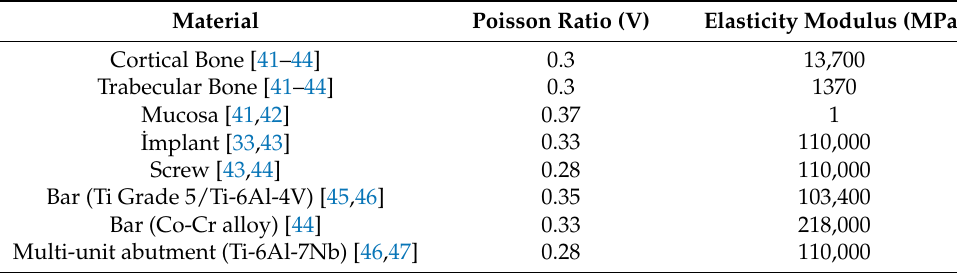
Table 1. The elasticity modulus and the Poisson ratio of each material used in this study. Material Poisson Ratio (V) Elasticity Modulus (MPa) Cortical Bone [41–44]